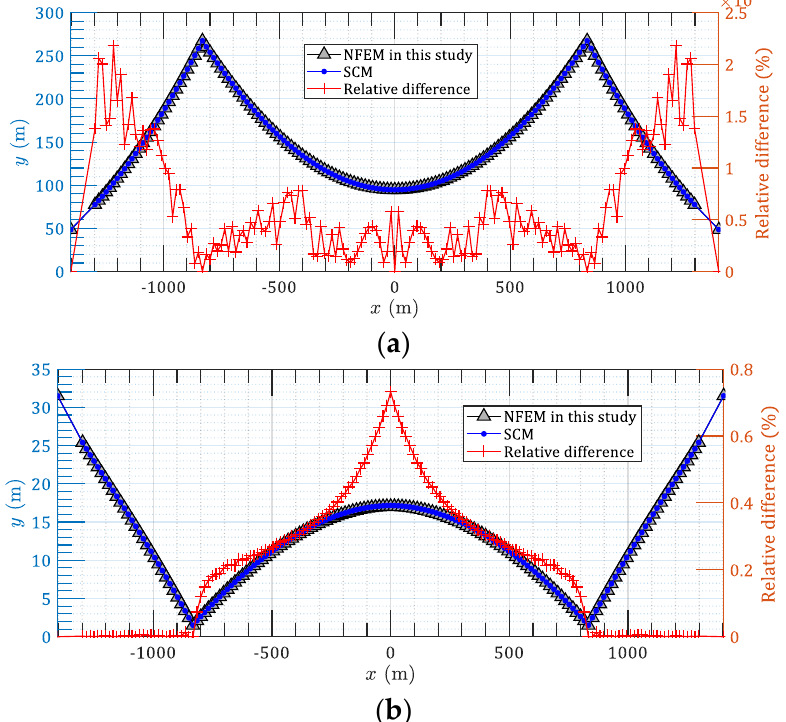
Figure 14. Comparison of the cable shape obtained from the NFEM and SCM for 3D spatial main cables: ( a ) y -direction; ( b ) z -direction.